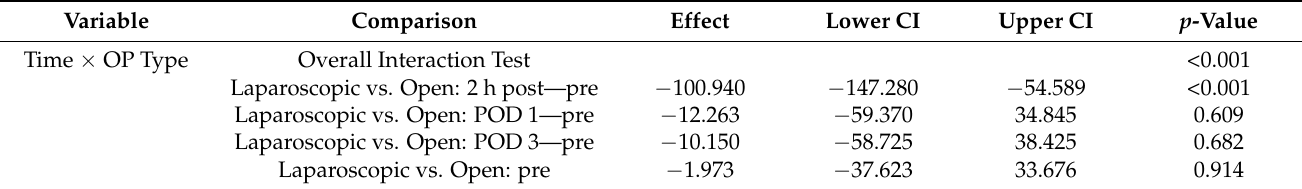
Table A1. Multivariable regression model